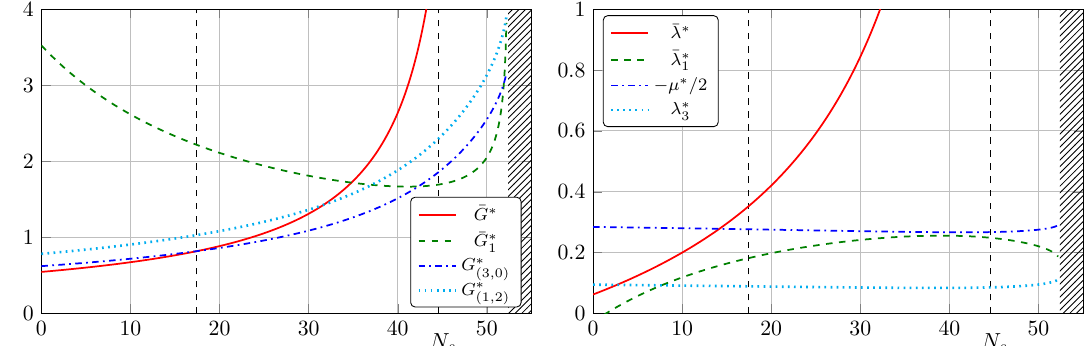
Figure 10: Comparison of background, level-one and fluctuation avatars of the New- ton coupling (left panel) and the cosmological constant (right panel). All couplings are evaluated with the input of the full fluctuation system on the right-hand side. ≈ 17.5 and N ≈ 44.6 show where η ( 0 ) and η ( k 2 ) exceed The vertical lines at N s s h h two,